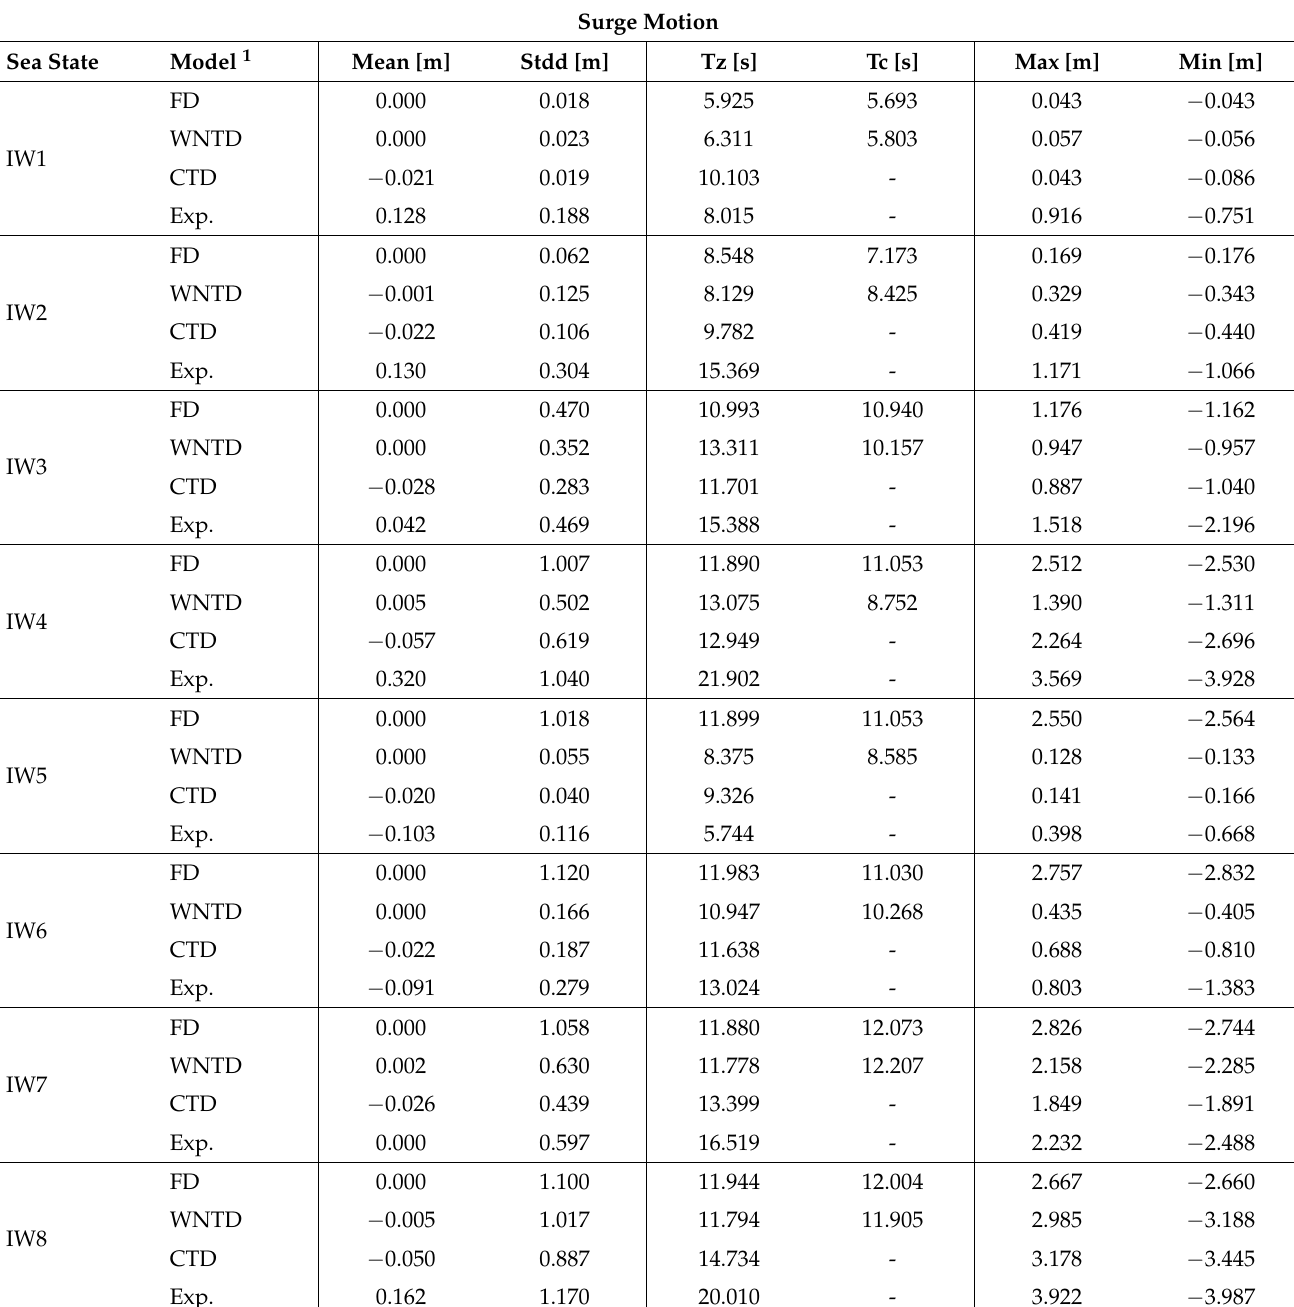
Table 6. Surge motion statistics in irregular wave conditions according to different